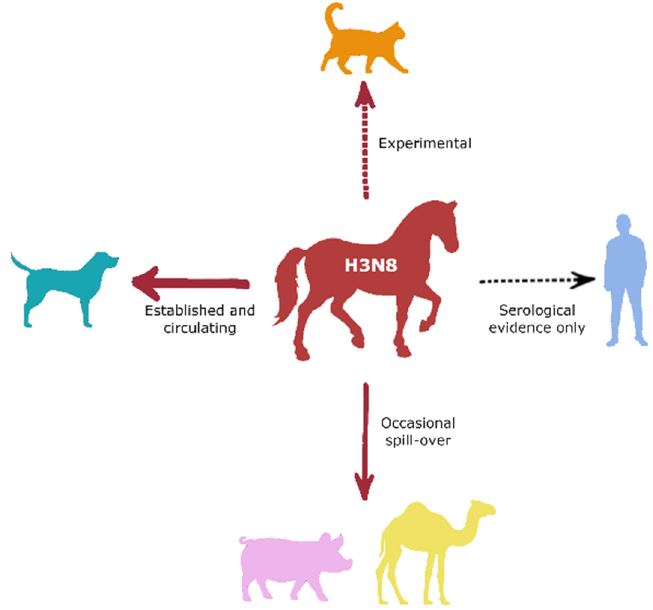
Figure 2. Cross-species transmission of equine influenza A virus H3N8. Thick solid red arrow represents direct transmission event that has since become established and now circulates within the species. Thin red arrow represents isolation from the species as likely spill-over events. Dashed red arrow represents isolation following experimental exposure only. Dashed black arrow represents serological evidence of exposure only, from field or experimental sources.